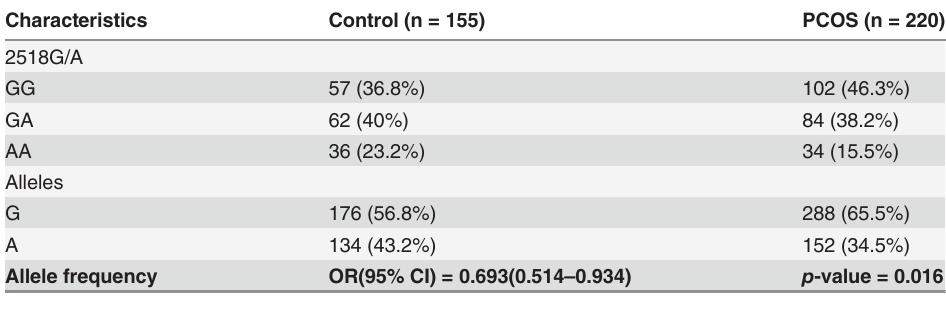
Table 3. Allele frequencies of G/A polymorphisms of the MCP-1 gene in controls (n = 155) and poly- cystic ovary syndrome (PCOS) patients (n =